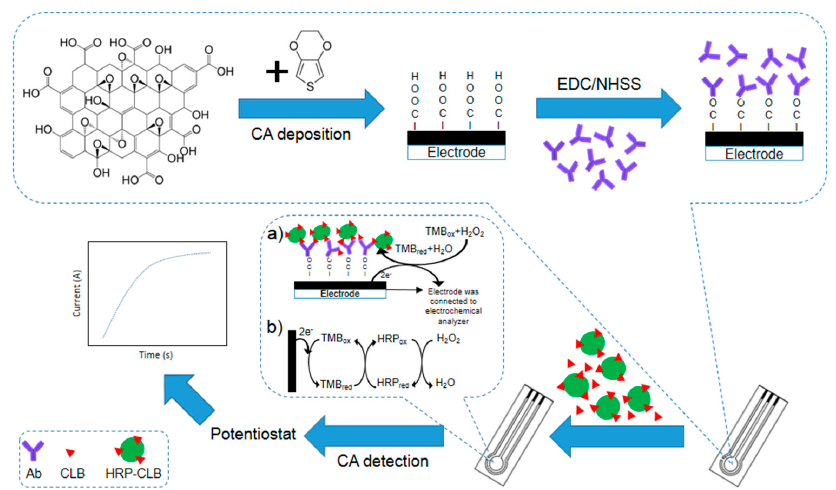
Figure 1. Schematic diagram of fabrication of clenbuterol hydrochloride (CLB) immunosensor. ( a ) Electrochemical immunosensor format used for CLB detection; ( b ) Indirect electron transfer for TMB redox shown by complex TMB/HRP/H 2 O 2 enzyme reaction on modified SPCE for reduction current formation.